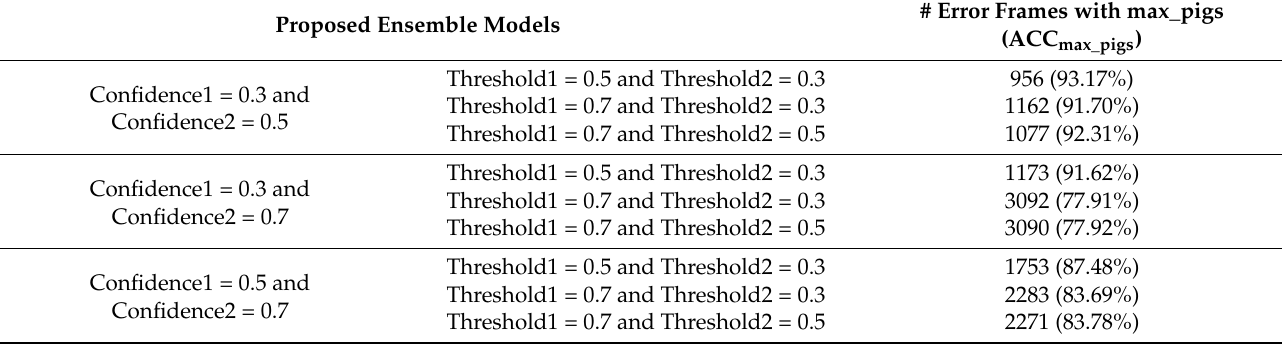
Table 7. Comparison of accuracy ACC max_pigs for 13,997 key frames with overexposed regions (obtained during 8:30 a.m. to 10:30 a.m.) with different ensemble parameters (case of Confidence1 and Threshold1 = conservative, Confidence2 and Threshold2 = aggressive).